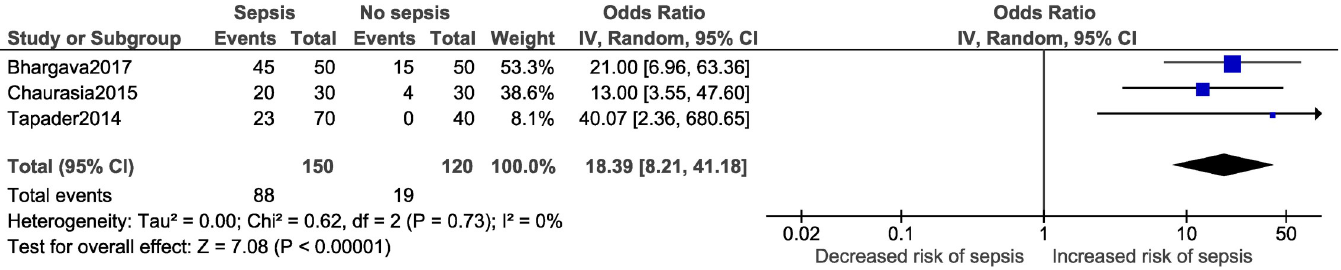
Fig 7. Forest plot showing a random-effects meta-analysis of neonates requiring artificial ventilation, with and without sepsis.